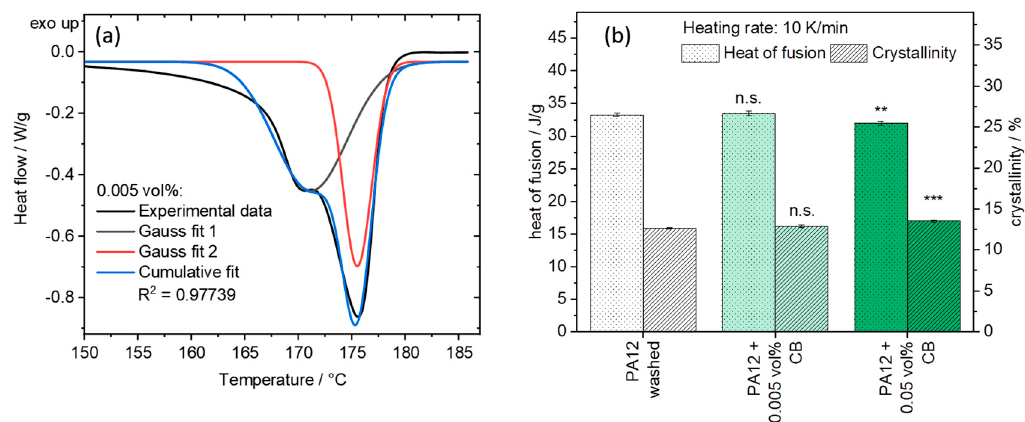
Figure 10. ( a ) Exemplary determination of the heat of fusion of both peak areas from the DSC second heating curve and ( b ) heat of fusion and crystallinity of PA12 and its composites after colloidal additivation calculated from the DSC data. No significant changes are visualized with n.s. ( p > 0.05) and significant differences with asterisks ** ( p ≤ 0.01) and *** ( p ≤ 0.001).